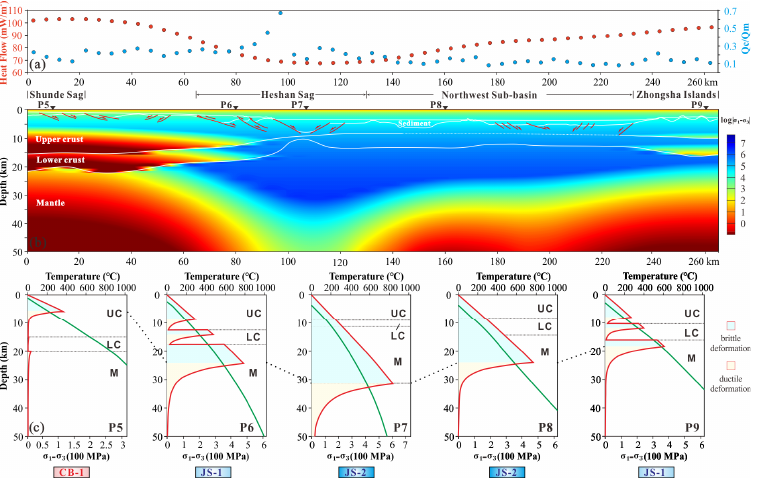
Figure 8. ( a ) The values of Q c /Q m and surface heat flow are represented by the blue points and red points, respectively. ( b ) The constructed lithospheric rheological structure of profile L2. ( c ) The thermo ‐ rheological models estimated at the typical locations of P5 − P9. Green and red lines denote the geothermal curve and yield stress envelope (YSE), respectively. The classical rheological models of JS − 1, JS − 2, and CB − 1 were recognized along profile L1 by the light blue, dark blue, and pink rectangles, respectively. JS − 1, jelly sandwich regime with weak lower crust; JS − 2, jelly sandwich regime with relatively strong lower crust; CB − 1, crème brûlée regime with weak lower crust. Q c , crustal heat flow; Q m , mantle heat flow; UC, upper crust; LC, lower crust; M, upper mantle. Similar lateral changing trends in rheological strength are also presented along pro ‐ file L2, with a stiff lithosphere in its central part, including the southern part of the Heshan Sag and the NSB (Figure 8). The NSB exhibits the typical rigidity and coldness of the oce ‐ anic lithosphere, with only one brittle layer and peak strength exceeding 500 MPa at the depth of 25 km (P8 in Figure 8). Unlike the rigid oceanic lithosphere, the Shunde Sag in the eastern PRMB exhibits a relatively weak continental lithosphere, with ductile defor ‐ mation distributed in the whole lower crust and upper mantle (P5 in Figure 8). Transi ‐ tional rheological structure characteristics are present at the Heshan Sag and Zhongsha Islands, which can be divided into four load ‐ bearing layers with a weak, ductile lower crustal layer sandwiched between two hard, brittle layers constituted by the upper crust and upper mantle (P6 and P9 in Figure 8). In particular, the southern part of the Heshan Sag begins to exhibit characteristics similar to the rigid oceanic lithosphere, which may indicate a heavily thinned continental crust between the normal continent crust and ocean crust (P7 in Figure 8).